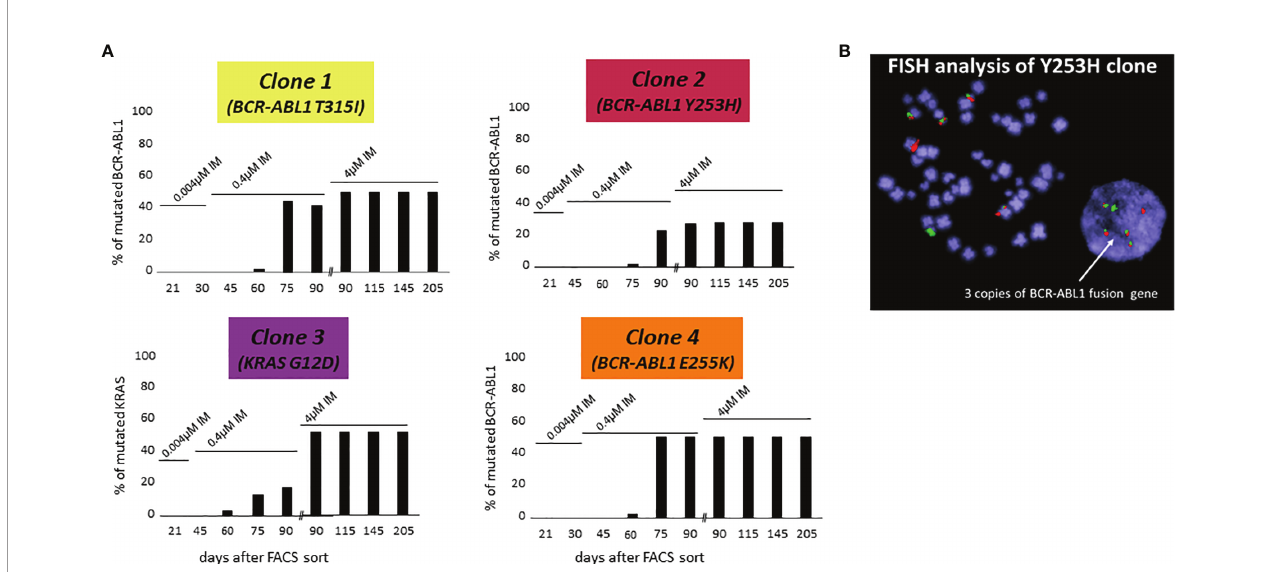
FIGURE 1 | De novo acquisition of somatic mutations during the development of KCL-22 clones of CD38- cell of origin resistant to 4 µM imatinib. KCL-22R clones were prepared by single cell FACS sorting into medium with 0.004 µM imatinib. The imatinib concentration was increased to 0.4 µM in day 31 and further increased to 4 µM in day 75 after sort. (A) The presence of mutated mRNA for BCR-ABL1 or DNA for KRAS during the development of resistant KCL-22R clones up to day 205 post single-cell FACS sorting: Clone 1, Clone 2, Clone 3 and Clone 4. No BCR-ABL1/KRAS mutations were detected in KCL-22R clones until days 60-75 postscoring after the escalation of the imatinib concentration up to 0.4 µM. The growing concentration of imatinib is indicated above the columns. The presence of mutation in day 90 was determined both in the culture with 4 µM imatinib and in the precedent culture with 0.4 µM imatinib growing simultaneously. (B) FISH analysis XL BCR/ABL DF of Clone 2 (Y253H) revealed the presence of 3 BCR-ABL1